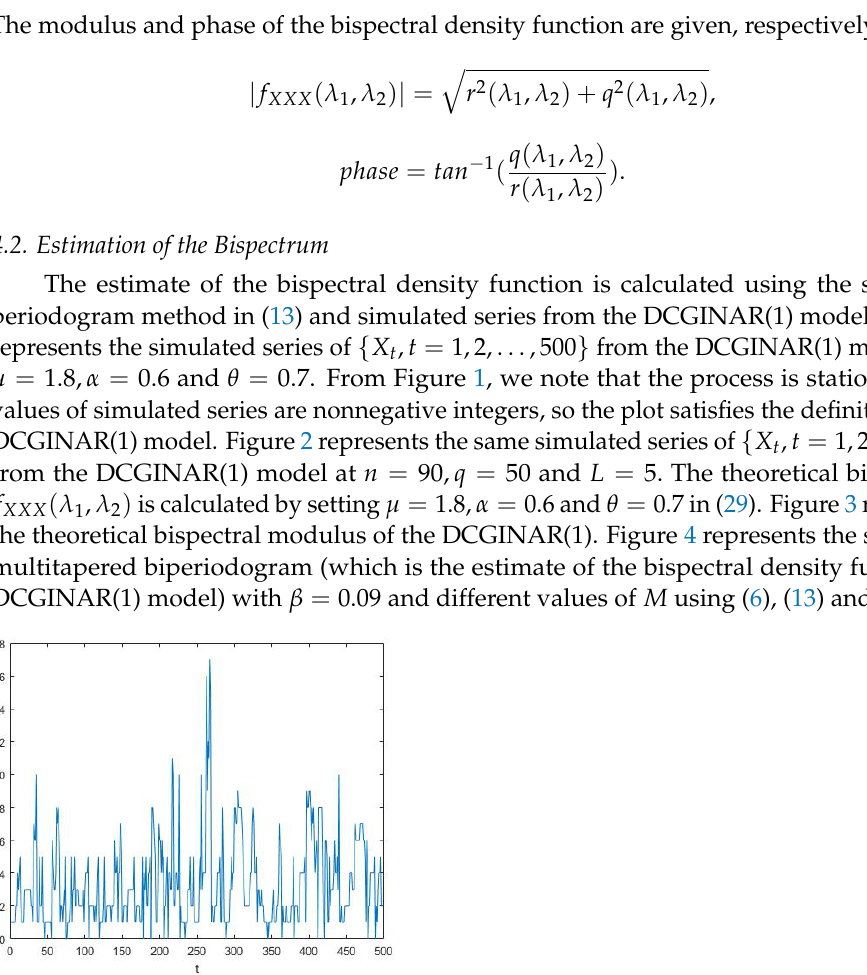
Figure 1. The simulated series of the DCGINAR(1) model at α = 0.6, θ = 0.7.